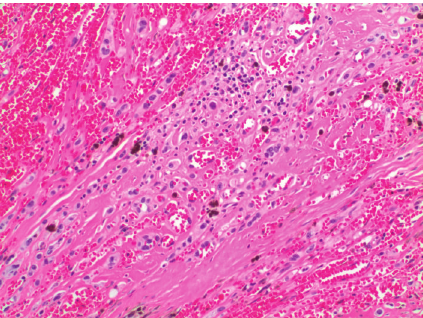
Figure 3: An area more typical of epithelioid hemangioendothe- lioma, a low-grade malignancy, with cords of tumor cells in a hyalinized stroma. Some cells show intracytoplasmic vacuoles with red cells, suggestive of primitive vascular spaces.